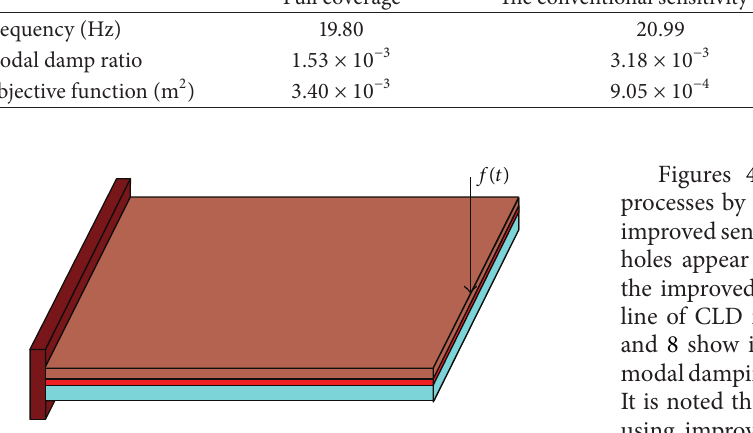
Figure 3: The cantilever CLD